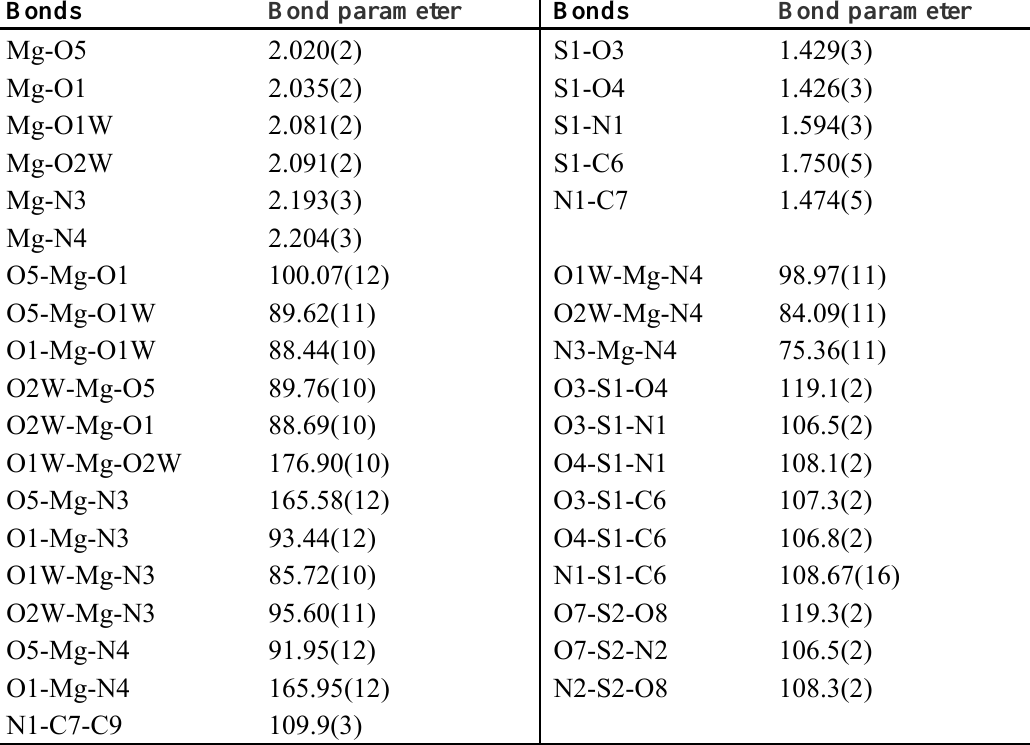
Table 2. Selected bond lengths ( Å ) and angles ( ° ) for Mg(II)